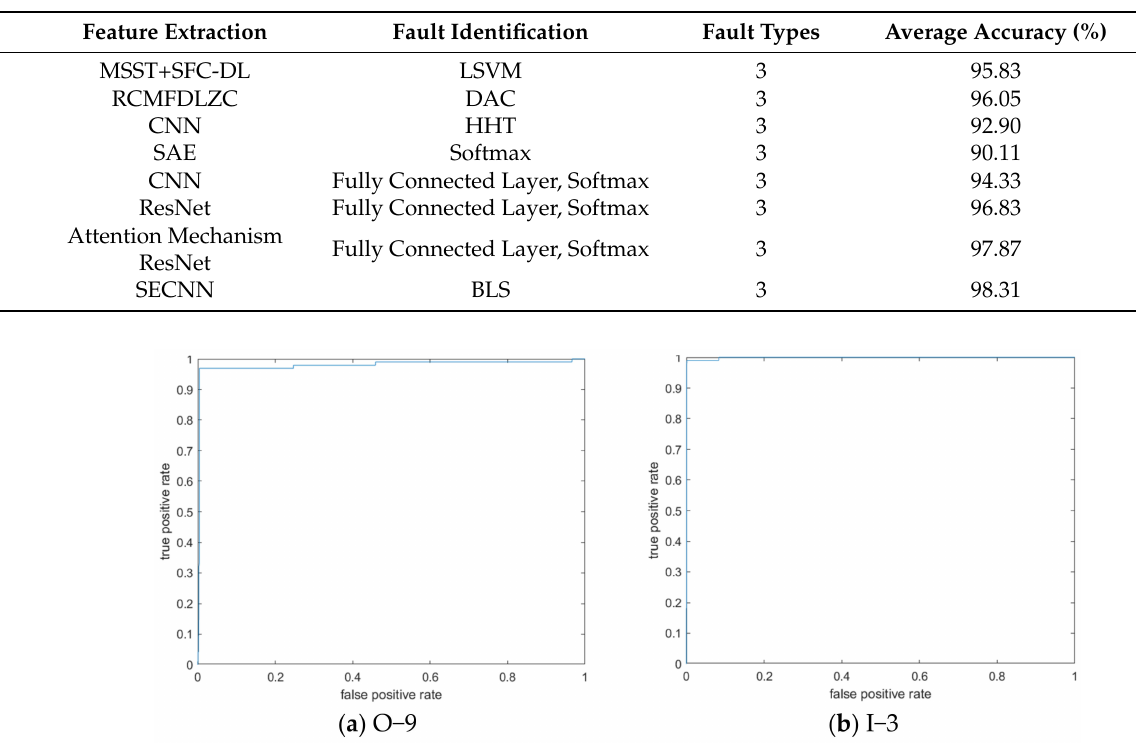
Table 3. Results of fault diagnosis accuracy compared with other methods on the MFPT dataset.